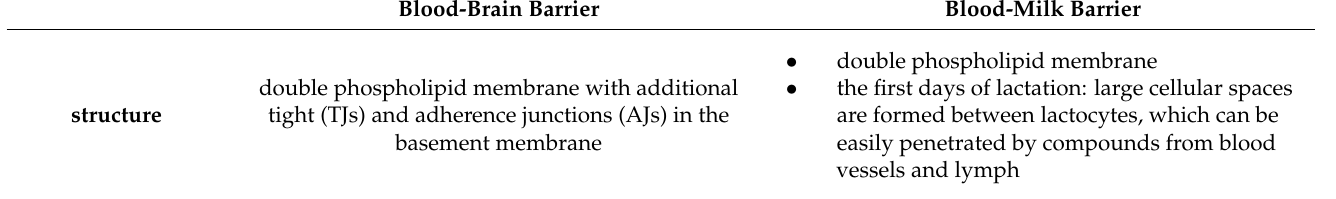
Table 1. Differences and similarities between blood-brain barrier and blood milk barrier. Blood-Brain Barrier Blood-Milk Barrier • double phospholipid structure basement membrane